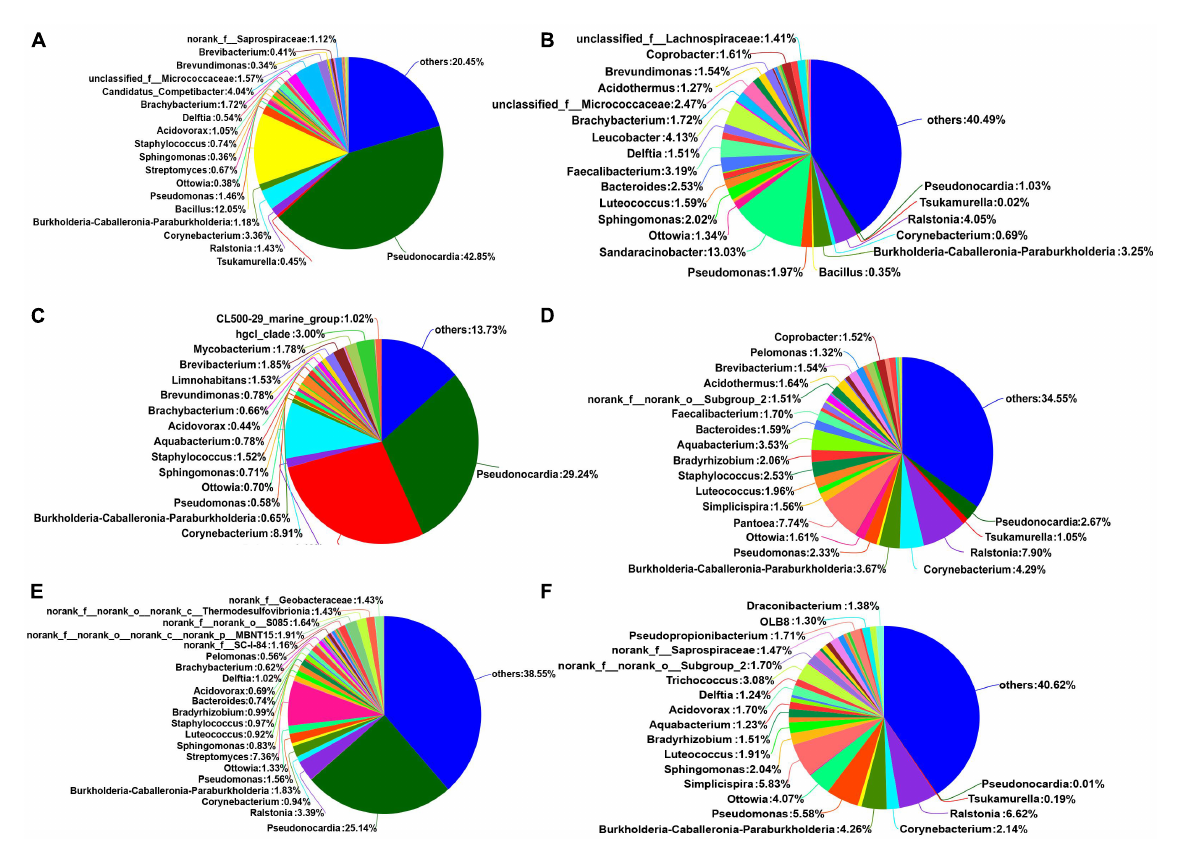
FIGURE4 Relative abundances of endophytic bacterial communities in different treatments at the genus level ( n = 3/treatment). (A) Green_coat, (B) Green_seed, (C) Yellow_coat, (D) Yellow_seed, (E) Red_coat, (F)